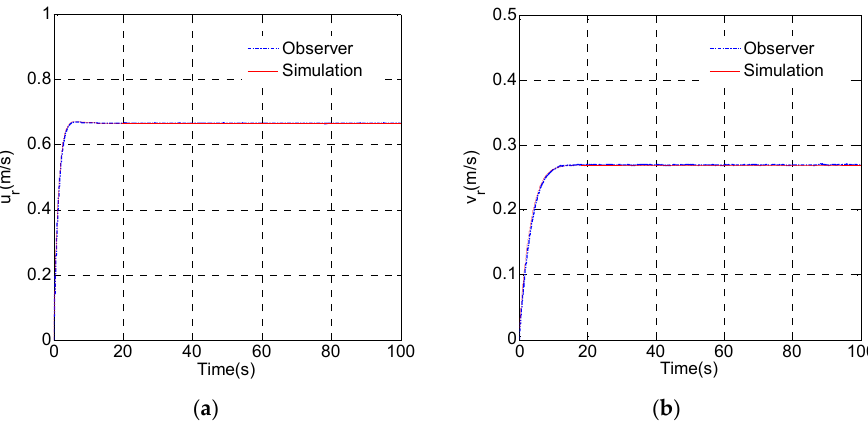
Figure 10. Observed results of relative velocity: ( a ) relative velocity of ROV in the x direction of body-fixed frame; ( b ) relative velocity of the ROV in the y direction of body-fixed frame.